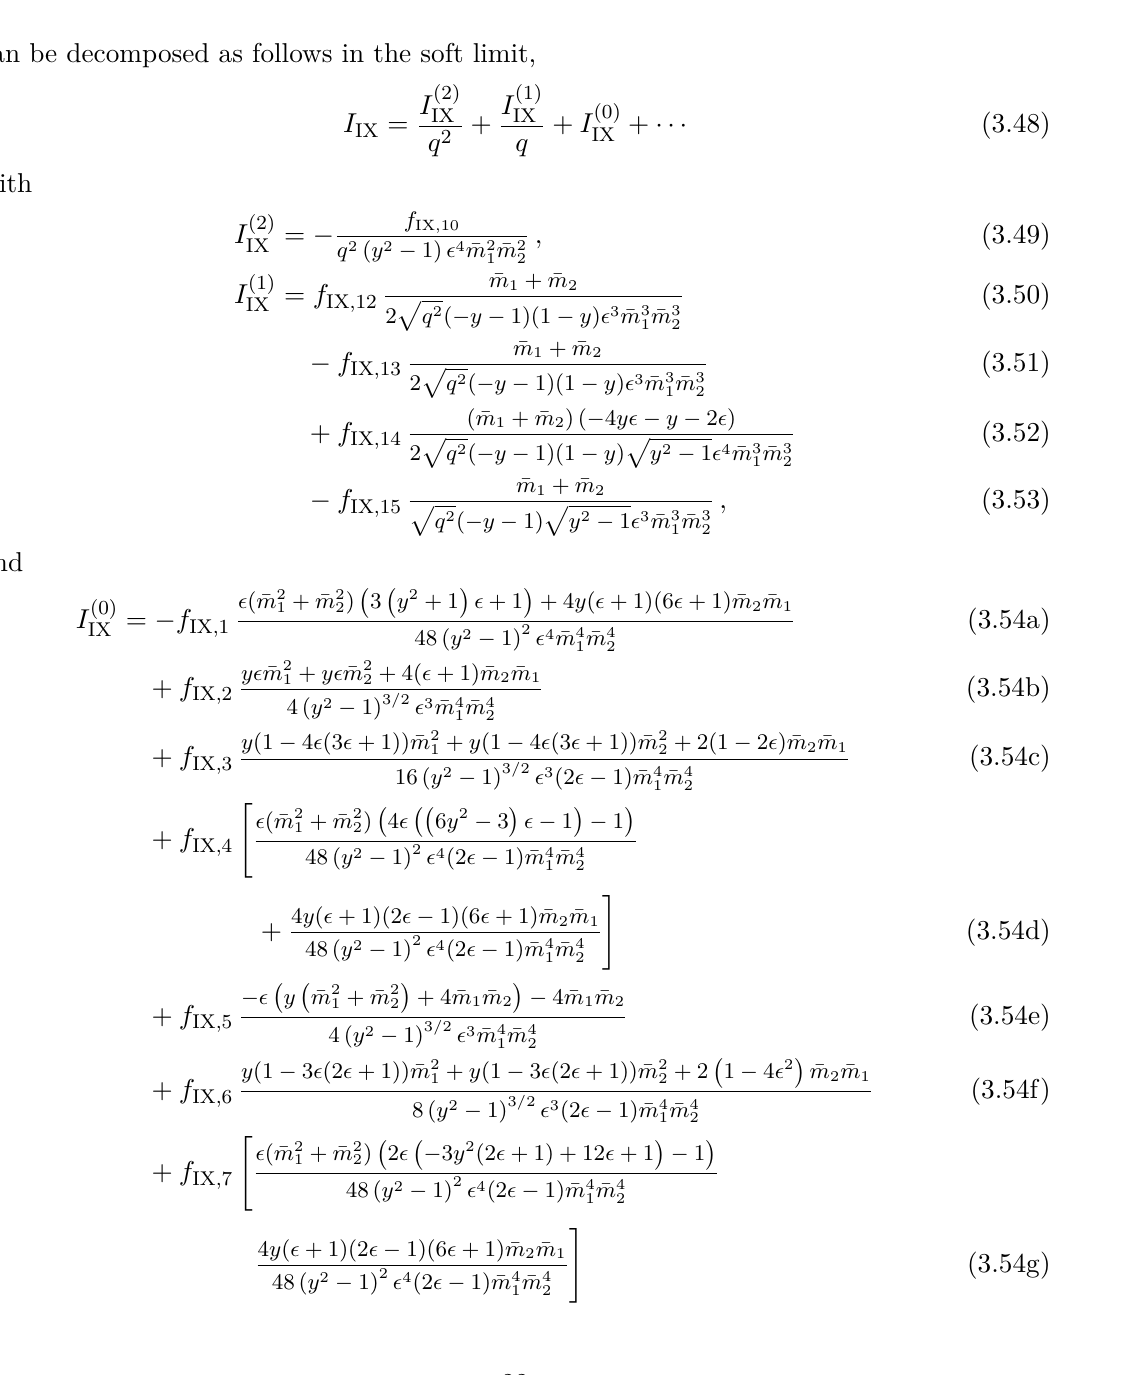
Figure 4. The nonplanar box